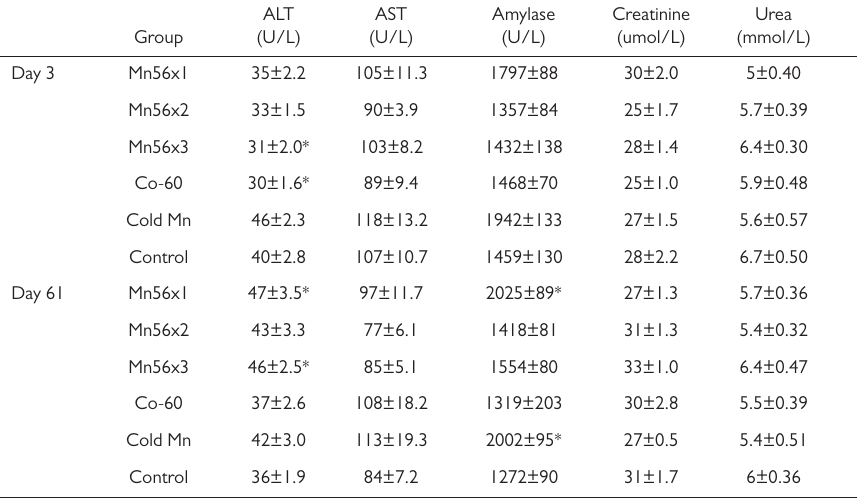
, Co-60 γ -rays and cold MnO 2